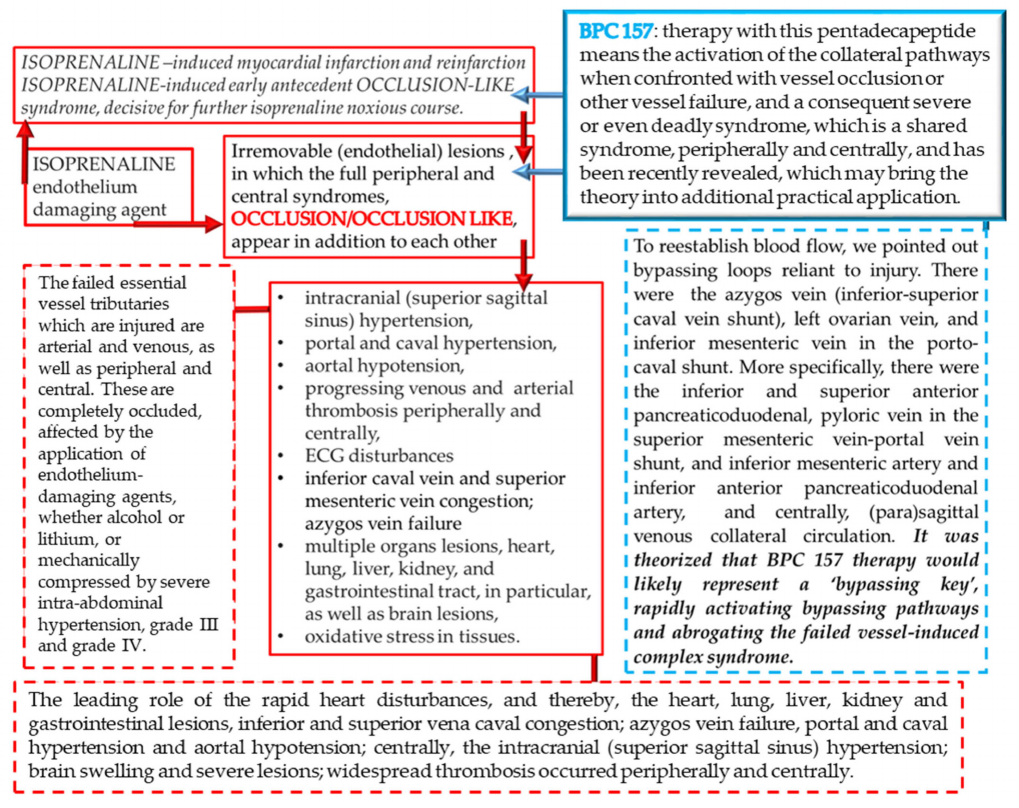
Figure 20. Summary of the background of the isoprenaline effects (red frameworks) and therapy potential of BPC 157 application (blue frameworks) [14–23]. It is likely that isoprenaline, via sub- cutaneous administration, indicates irremovable (endothelial) lesions (red frameworks), in which the full peripheral and central syndromes appear in addition to each other (red frameworks) as also noted with intragastric absolute alcohol-induced, over-dose lithium-induced and maintained intra- abdominal hypertension-induced occlusion-like syndrome (red dashes frameworks) [21–23]. Due to the prime peripheral or central lesion, these lesions should appear as an essential cause–consequence cycle (red dashes frameworks) [14–23]. BPC 157 therapy means the activation of the collateral path- ways when confronted with vessel occlusion or other vessel failure, and a consequent severe or even deadly syndrome, which is a shared syndrome, peripherally and centrally, and has been recently revealed, which may bring the theory into additional practical application (blue framework). Using the BPC 157 regimen, we commonly observed the counteraction of intracranial (superior sagittal sinus) hypertension, portal and caval hypertension, aortal hypotension, and progressing venous and arterial thrombosis peripherally and centrally; furthermore, ECG disturbances were attenuated. Multiple organ lesions, were also attenuated, including those of the heart, lung, liver, kidney, and gastrointestinal tract, in particular, as well as brain lesions. Oxidative stress in tissues were also atten- uated (blue dashes framework). Thus, this may be suitable background for the counteraction of the early isoprenaline-induced occlusion-like syndrome, and thereby, isoprenaline-induced myocardial infarction and